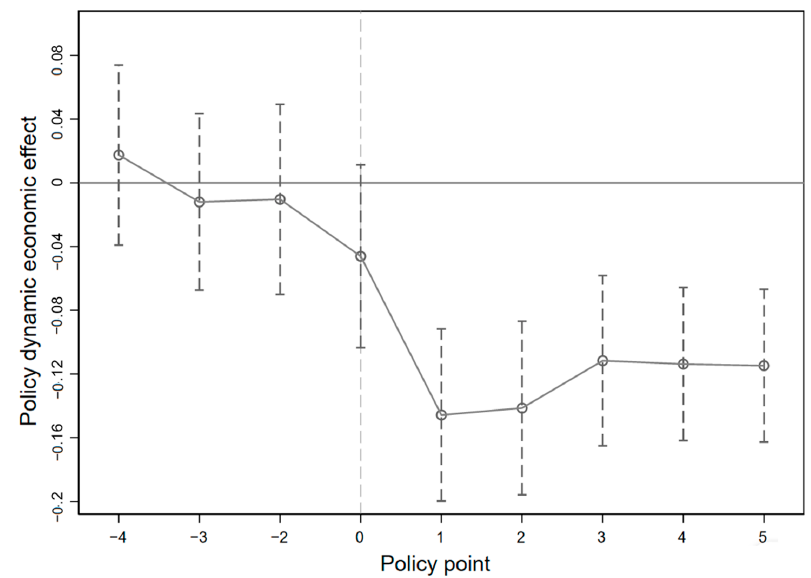
Figure 6. Parallel trend test and dynamic policy effect analysis of OLS.